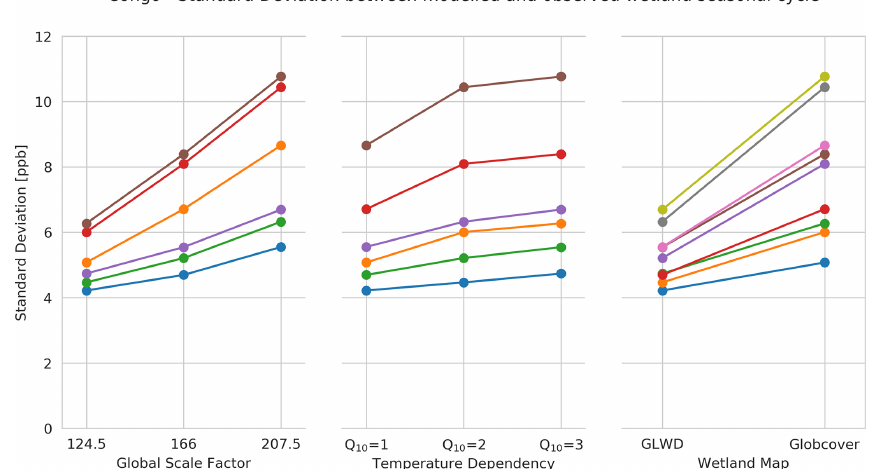
Figure 10. The standard deviation between the modelled and observed wetland CH 4 seasonal cycle for each of the three parameters that vary within the ensemble (global scale factor, temperature dependency and wetland map). Data points are joined together where the other two parameters are kept constant, and the only change is due to the specified parameter. This allows the influence of the change in each individual parameter to be